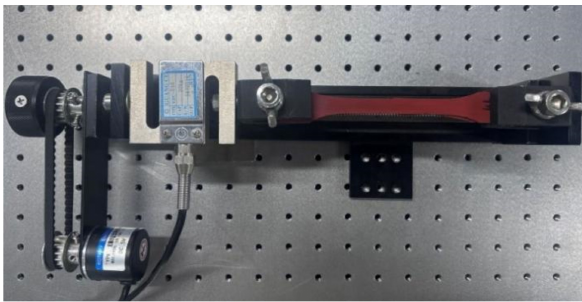
Figure 4. Uniaxial stress loading